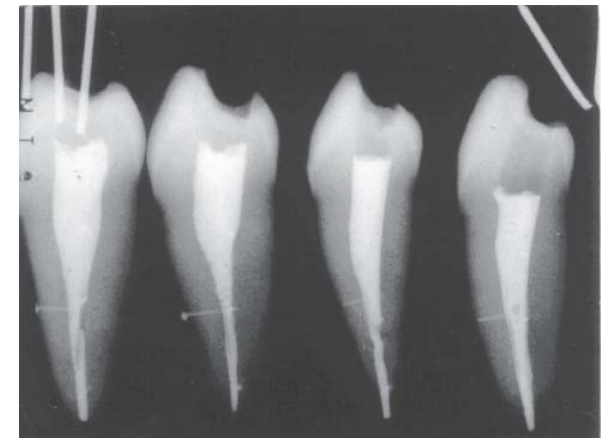
FIGURE 1- Radiograph image of teeth after the filling of the proximal lateral